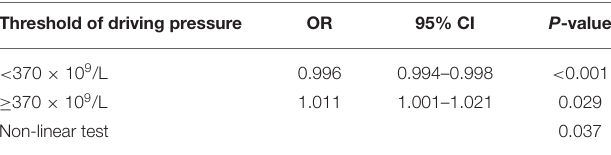
Adjusted for all covariates in Table 2